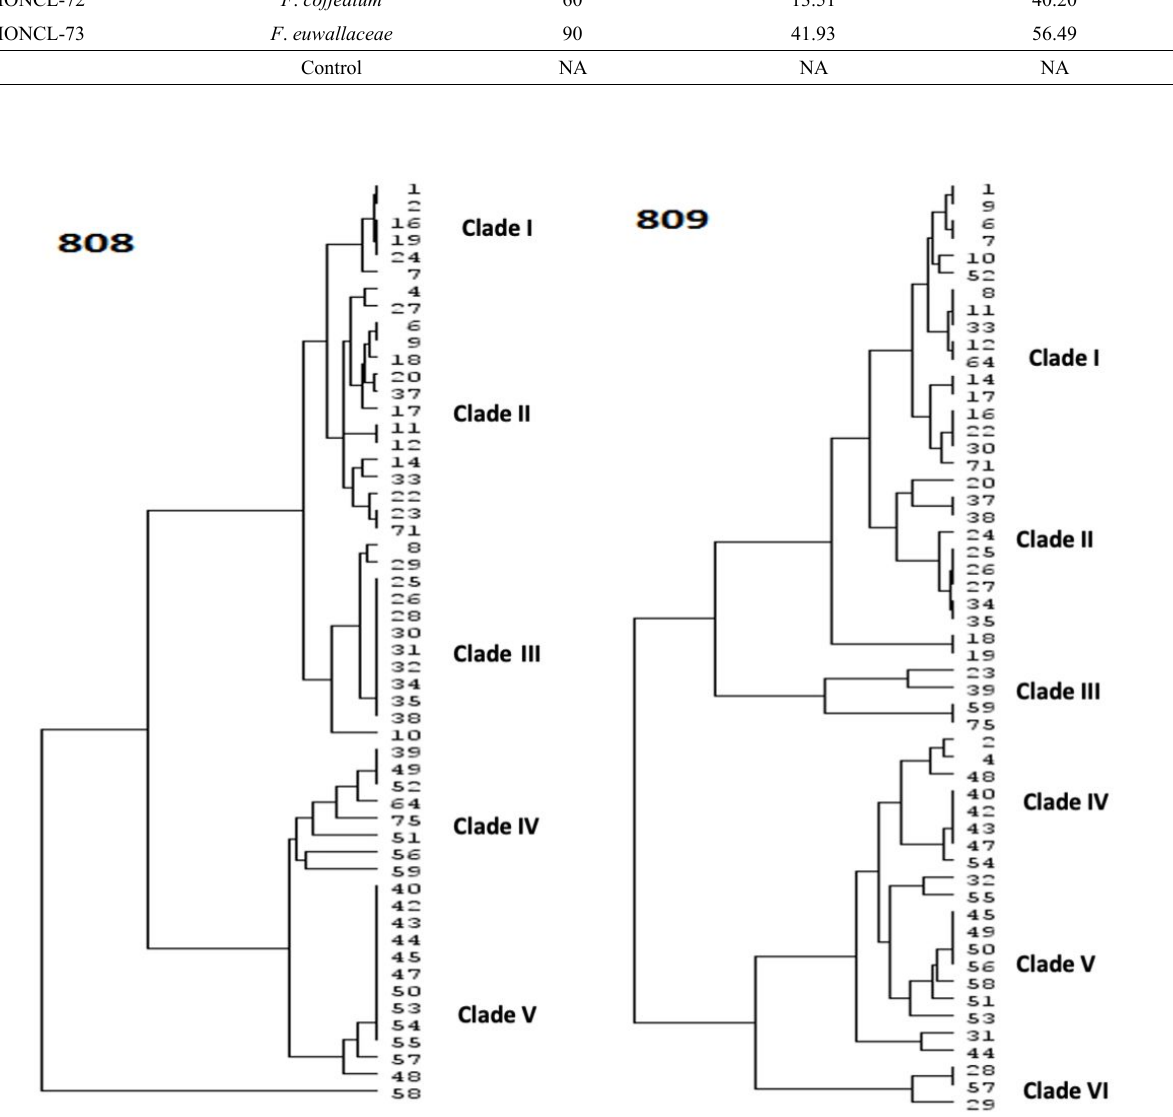
Figure 3 – Phylogenetic analysis of F . verticillioides strains by ISSR fingerprint (AG)